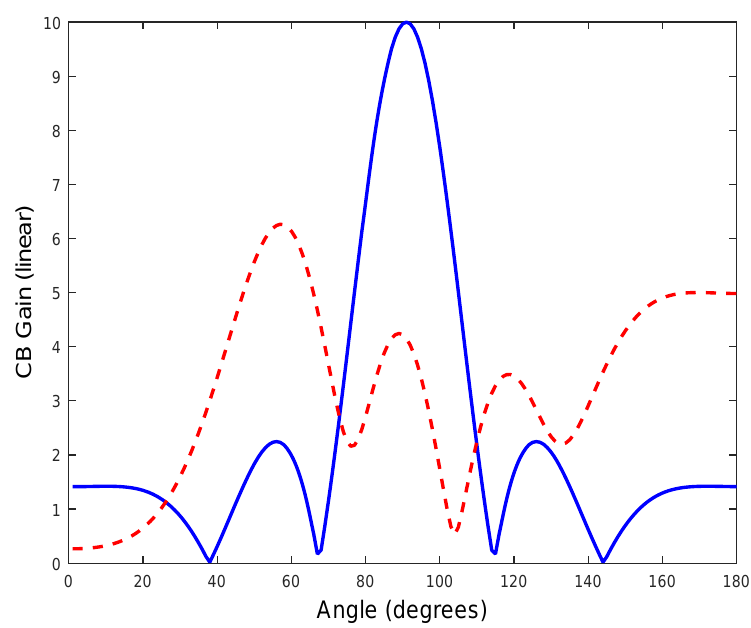
Figure 9. Ideal array pattern for 10 motes in an uniform linear array with perfect zero delays pointing to 90 ◦ and one randomized trial (dashed line) of CB using the experimentally obtained PDF to generate the delays.